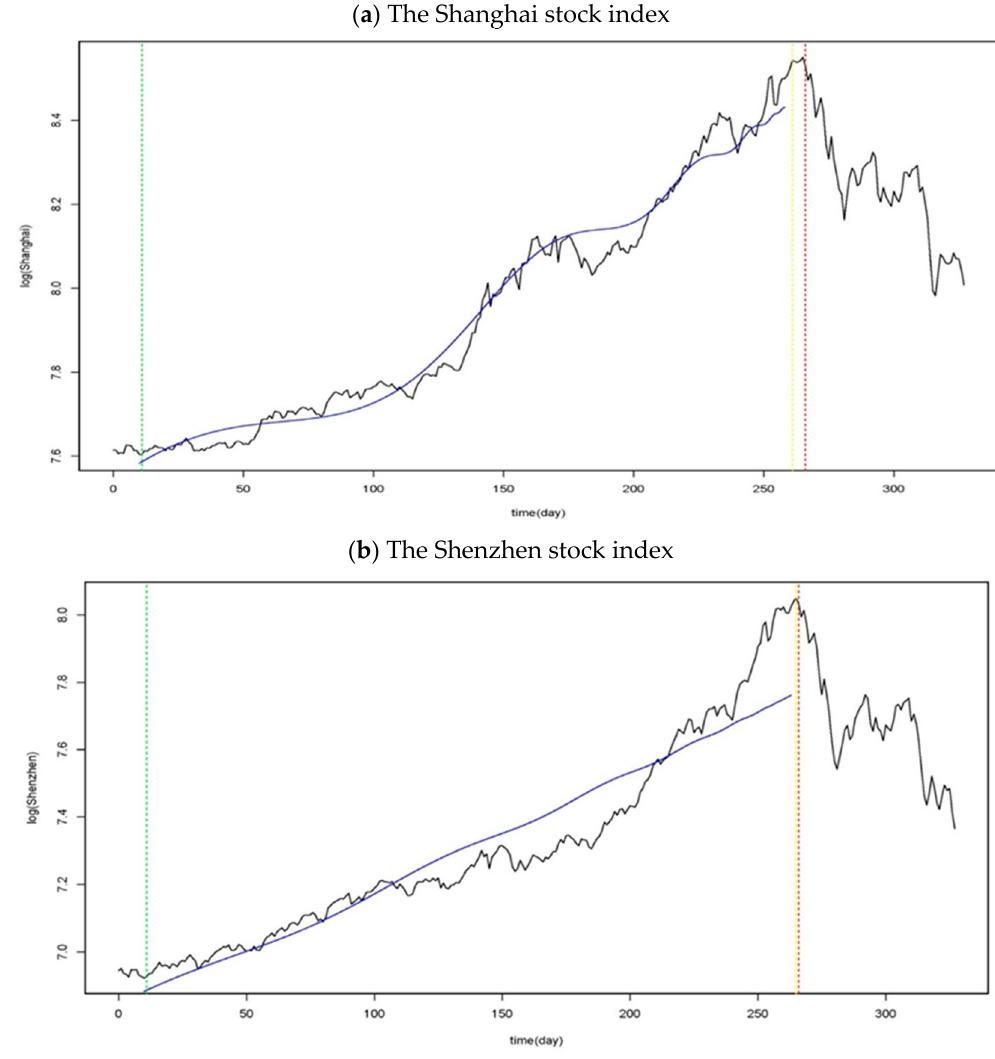
Figure 1. LPPL model calibration for: ( a ) The Shanghai stock index and ( b ) The Shenzhen stock index